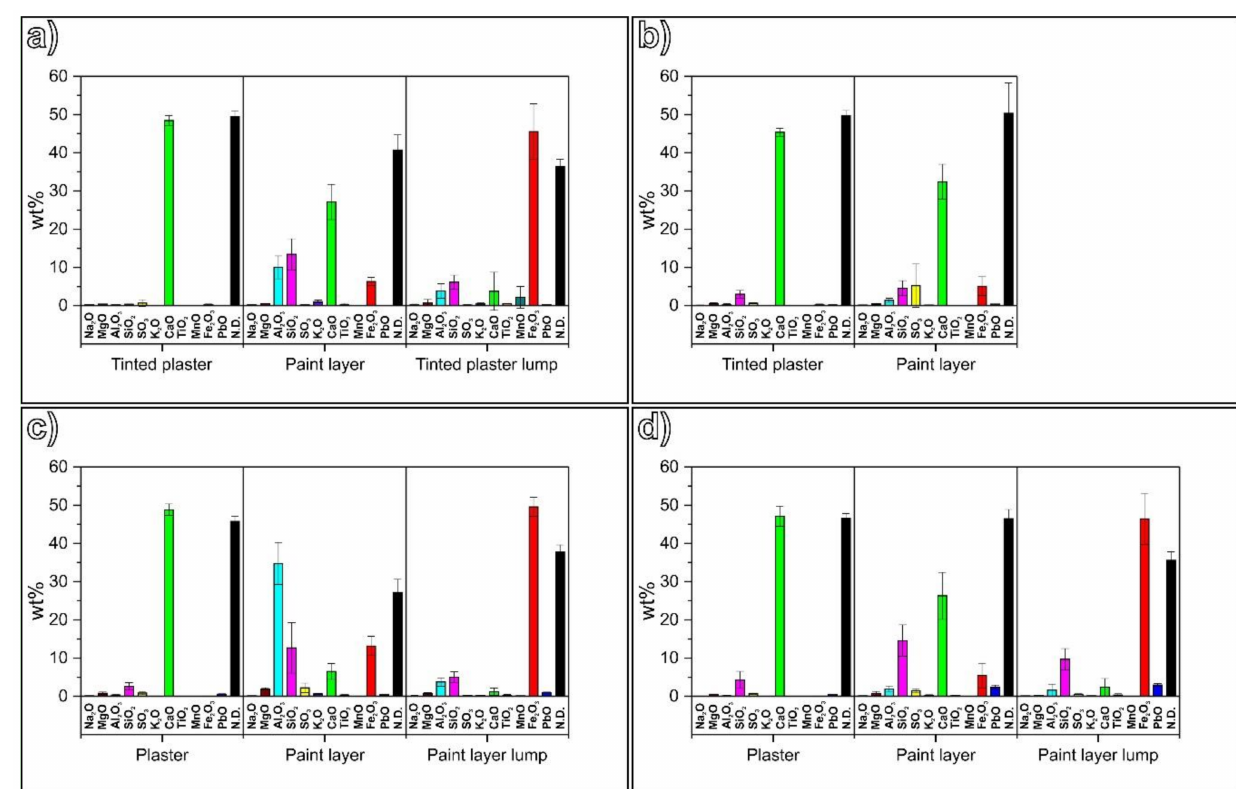
Figure 11. Histograms reporting mean compositional profiles of finishing plasters, paint layers, and pigment lumps (when available) in the samples analyzed through wavelength-dispersive X-ray spectroscopy system (EMP-WDS). Error bars are reporting the 95% confidence interval of the mean. ( a ) BCN_28; ( b ) BCN_W1_03; ( c ) BCN_51; and ( d ) BCN_67.